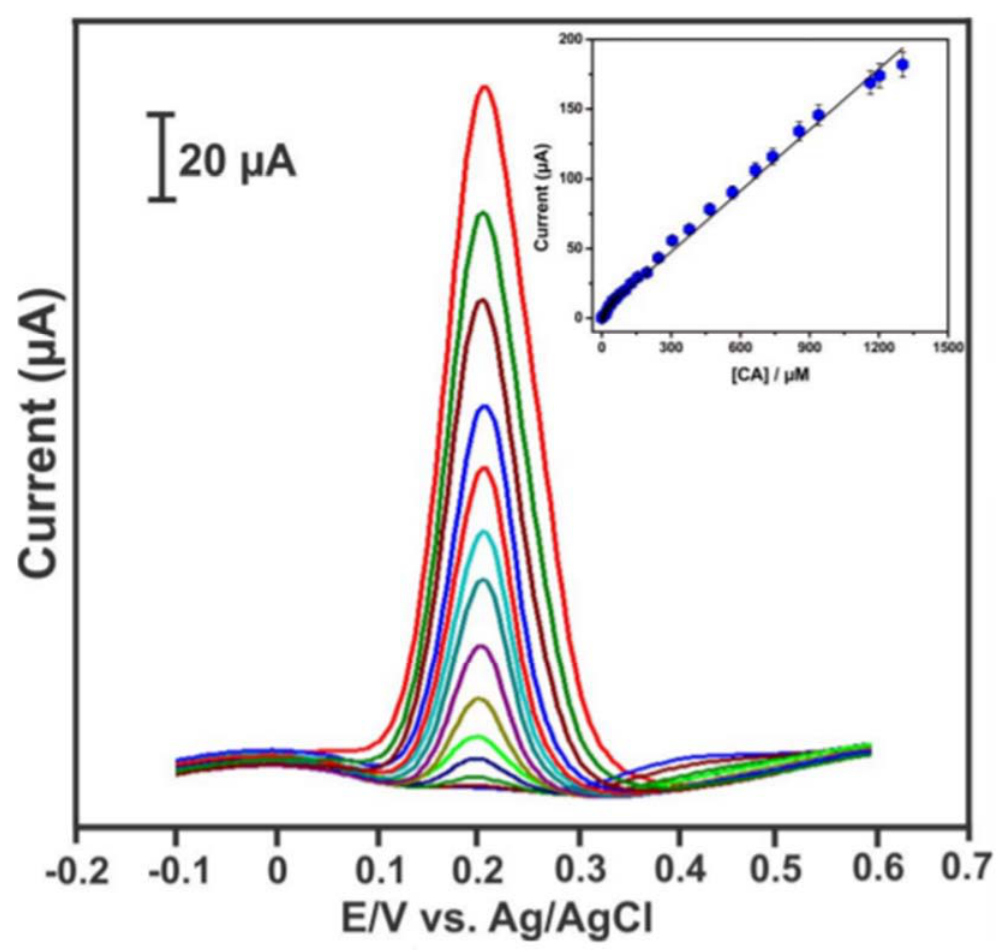
Figure 5. DPV response of the modified Au / PdNPs-GRF / GCE electrode for di ff erent CA concentrations from 0.03 to 938.97 µ M at pH 7.0. Inset is linear plot for DPV current response vs. [CA] [70]. Reprinted with the permission of the publisher.